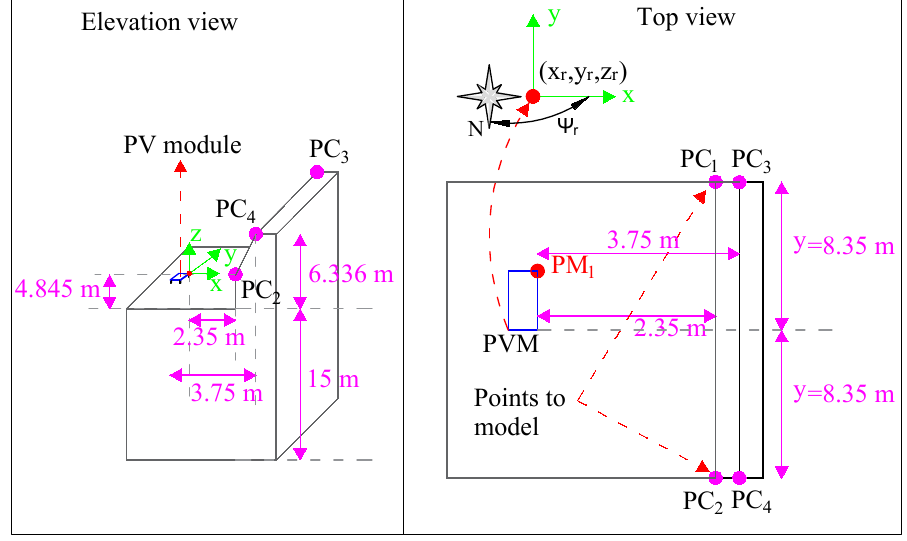
Figure 15. Geometry of the location of the PVM and the objects that can cast shadows. Left : depth view. Right : floor plan.